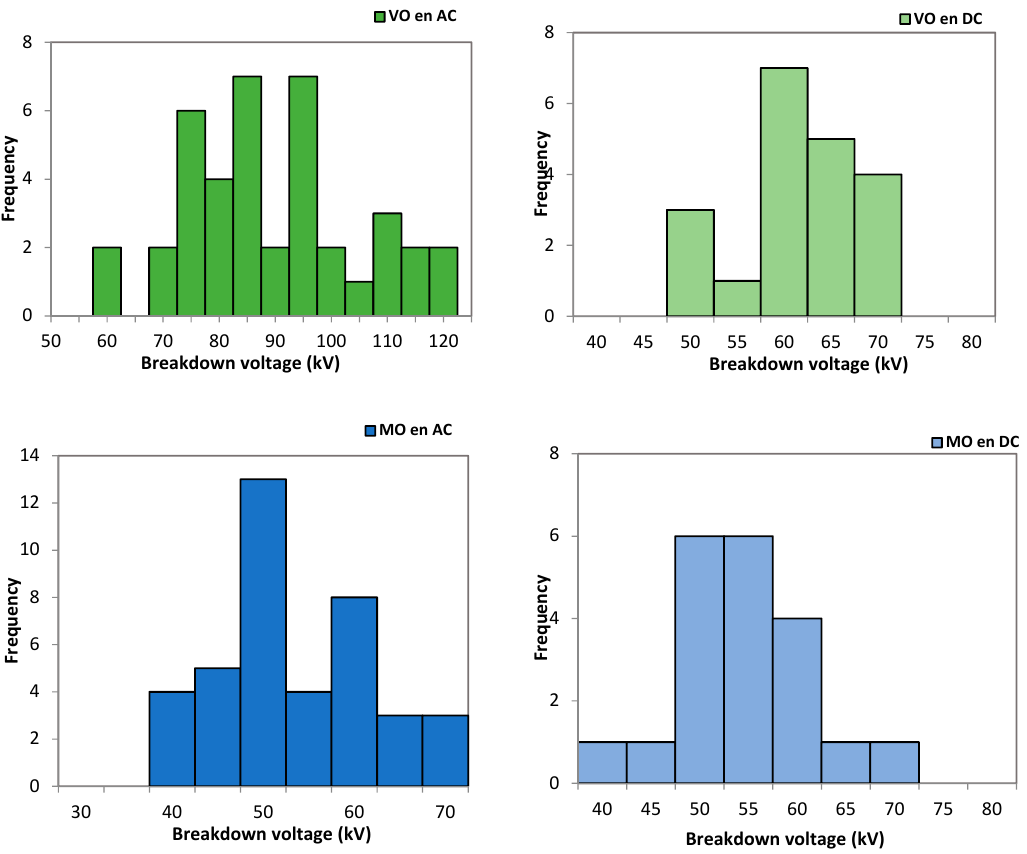
Figure 4. Histograms of AC and DC breakdown voltages of oils alone.